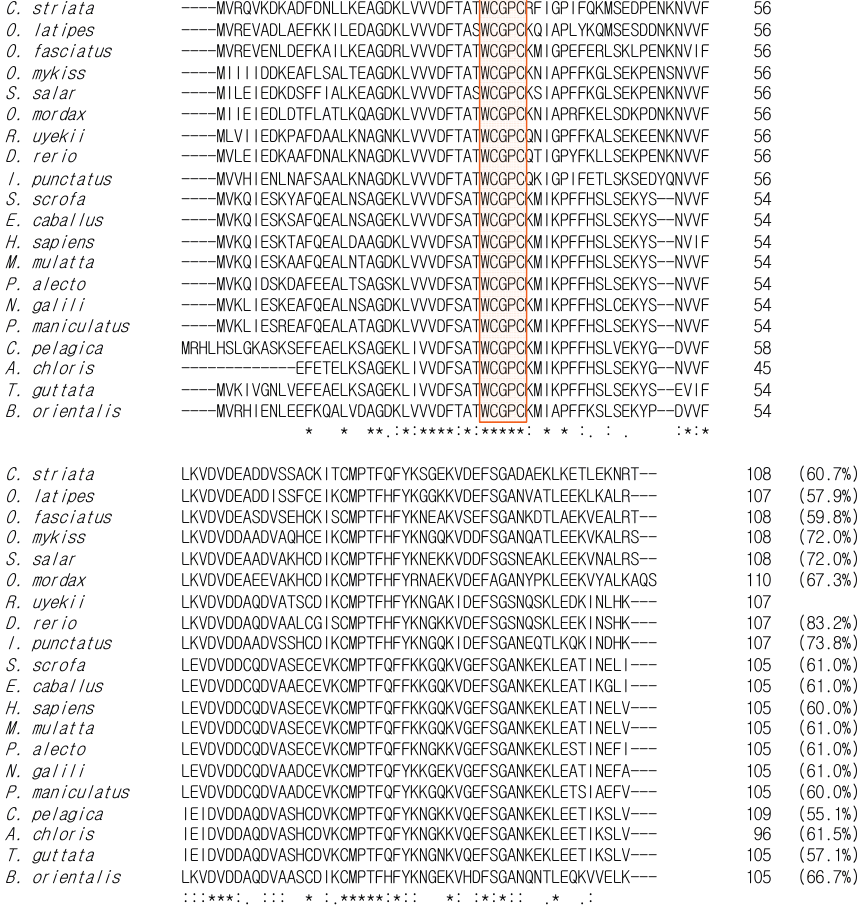
Figure 2. Multiple alignment of the deduced amino acid sequences of RuTrx with other species. Asterisk indicates identical residues at that position; colon denotes very similar residue at that position; dot indicates more or less similar, and no mark indicates no common property. Redox-active disulfide site, WCGPC, is boxed. The